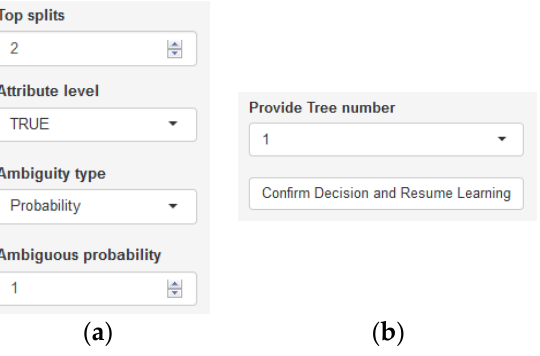
Figure 2. Additional parameters and sections in the Interactive Model